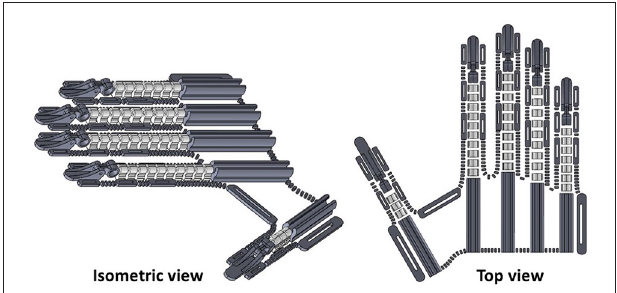
FIGURE 1 | Three-dimensional (3D) design of Hand Exoskeleton for Rehabilitation Objectives (HERO). Isometric view at left and top view at right.